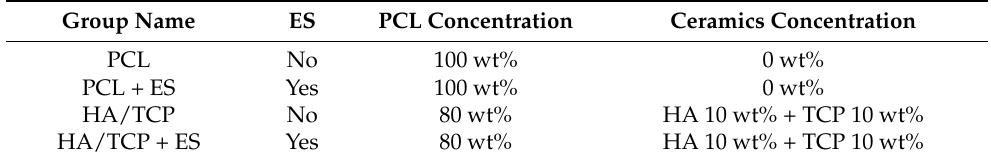
Table 1. Experimental groups for in vivo